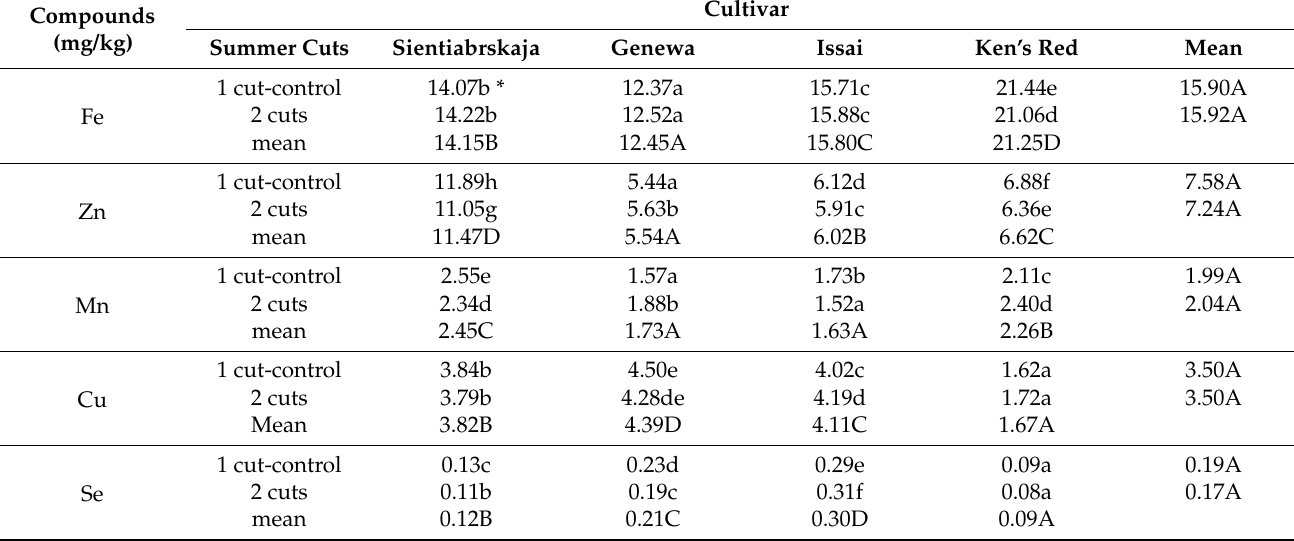
Table 3. The contents of micronutrients in the leaves and fruits of